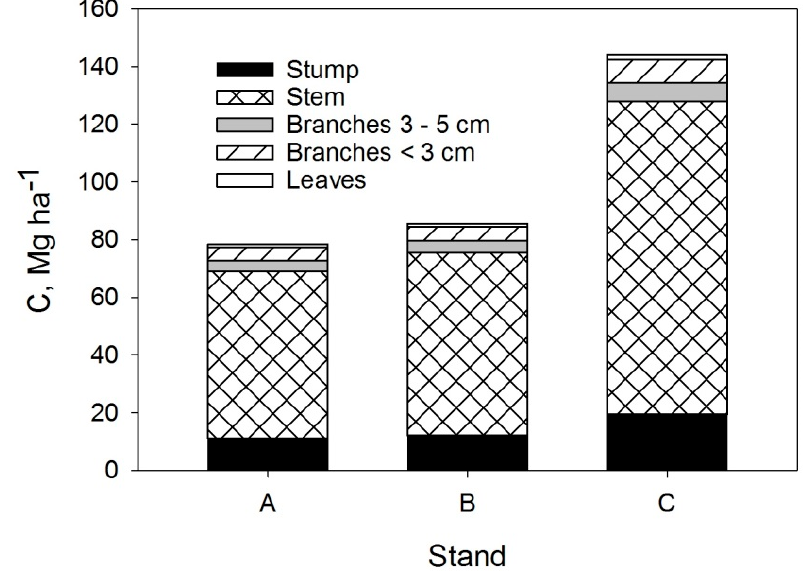
Figure 3. The amount of carbon (C) bound in different compartments of rubber tree plantations that were 20 years (stand A), 25 years (stand B), and 30 years (stand C) of age.